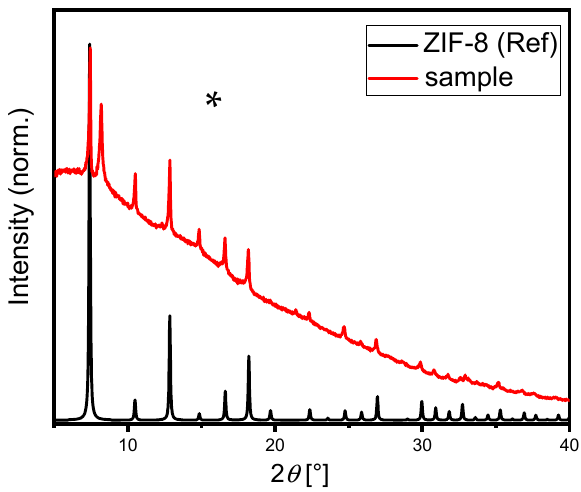
Figure 3. X-ray diffraction pattern of the deposited material (red) and corresponding ZIF-8 refer- ence [35] (black), Cu–K α 1 radiation, λ = 1.54056 Å. The signal at 8.5°, marked with an asterisk, does not belong to the Bragg reflections of ZIF-8 material and corresponds to Cu 2.5 SO 4 (OH) 3 *2H 2 O [36], which was formed as an admixture during anodic deposition of ZIF-8.